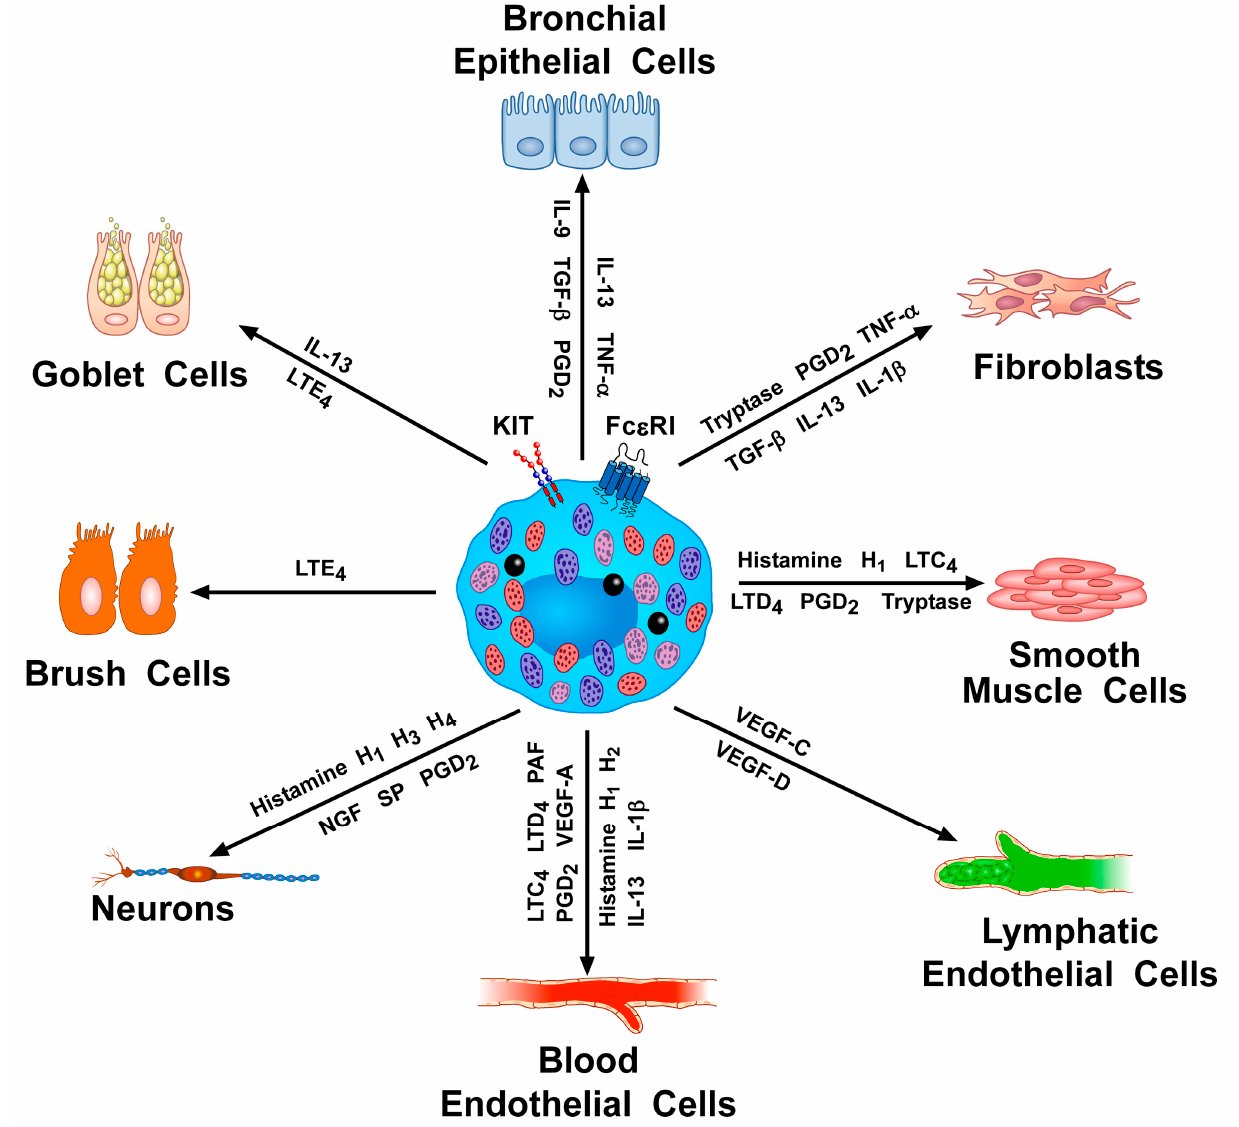
Figure 3. Schematic representation of the multiple interactions between human lung mast cells and various non-immune cells through the release of mediators. Mast cells can interact with bronchial epithelial cells (IL-13, TNF- α , IL-9, TGF- β , and PGD 2 ), brush cells (LTE 4 ), fibroblasts (tryptase, PGD 2 , TNF- α , TGF- β , IL-13, and IL-1 β ), smooth-muscle cells (histamine, LTC 4 , LTD 4 , PGD 2 , and tryptase), goblet cells (IL-13 and LTE 4 ), blood endothelial cells (histamine, LTC 4 , LTD 4 , PGD 2 , PAF, VEGF-A, IL-13, and IL-1 β ), lymphatic endothelial cells (VEGF-C and VEGF-D), and neurons (histamine, NGF, SP, and PGD 2 ). Modified with permission from Varricchi 2019 [151].